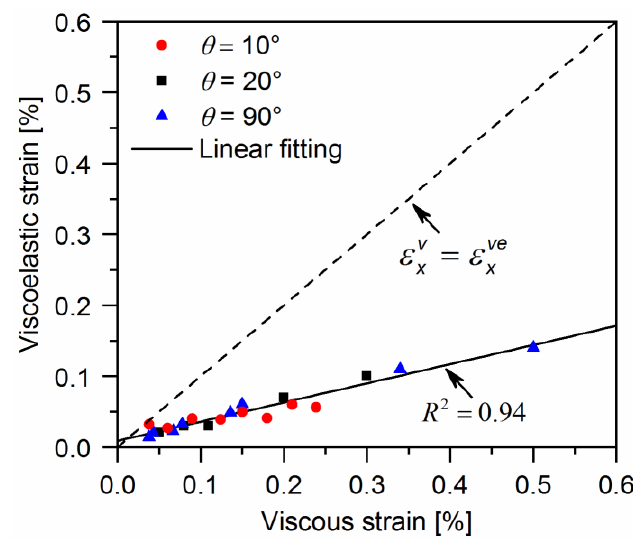
Figure 12. The relationship between the viscous strain and viscoelastic strain of a quasi-UD E-glass/polypropylene composite under off-axis tensile loading.